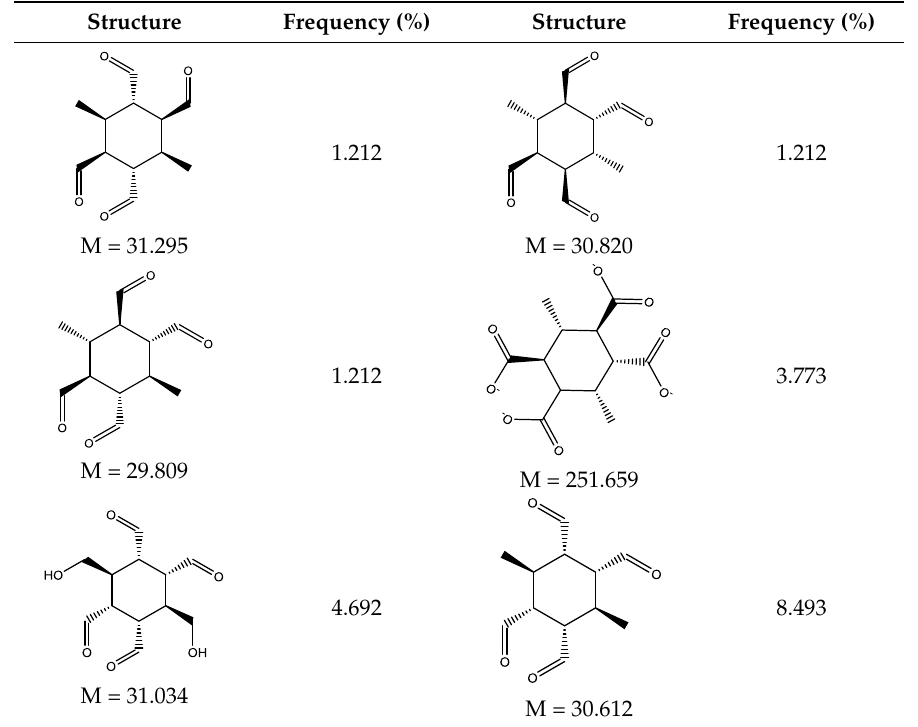
Table 7. RECAP analysis result: molecules represented as 2D formulas, molecular mass (M), and the corresponding frequency of appearance (%) in the analysis. Structure Frequency (%) Structure Frequency (%)